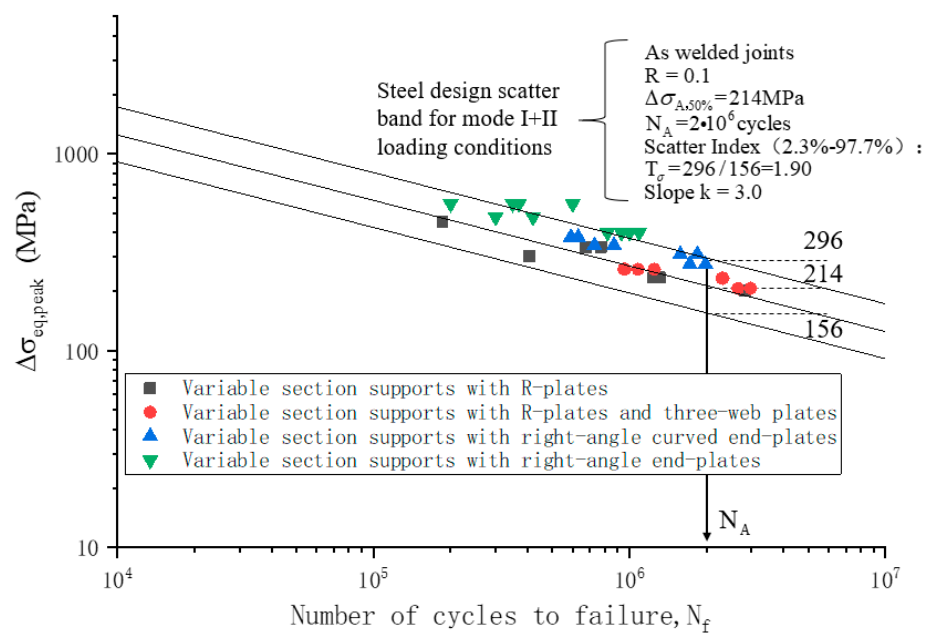
Figure 19. Comparison of fatigue strength derived from the proposed scatter band reported in Figure 3 and experimental results of variable-section supports. The scatter band is equal to the mean value ± two standard